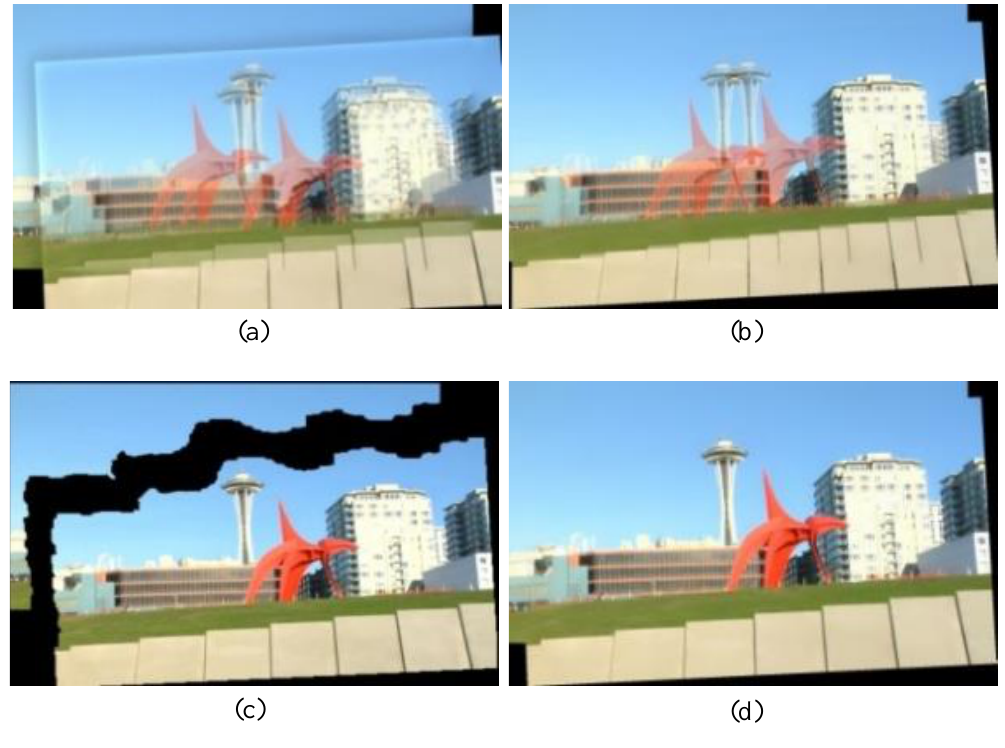
Figure 4. Examples of panoramas with ( a ) global projective warp and ( b ) layered warp, and seam selection results in ( c ). ( d ) is the final fused image according to selected seam in ( c ). The seam selection result ( c ) is based on stitched image ( b ) with layered